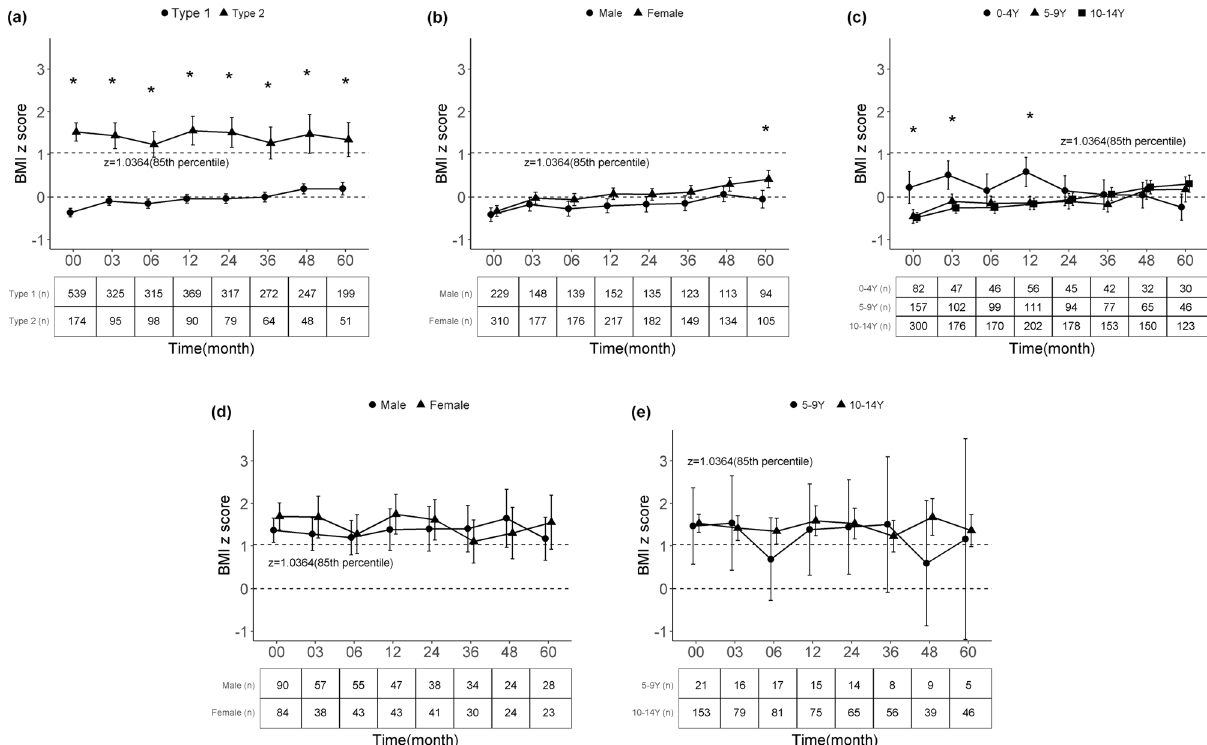
Figure 2. Trajectory of the average body mass index z-score over 5 years after diagnosis according to type of diabetes, sex, and age group. ( a ) All patients according to diabetes type, ( b ) type 1 diabetes according to sex, ( c ) type 1 diabetes according to age group, ( d ) type 2 diabetes according to sex, and ( e ) type 2 diabetes according to age group. *Bonferroni-corrected p -value <